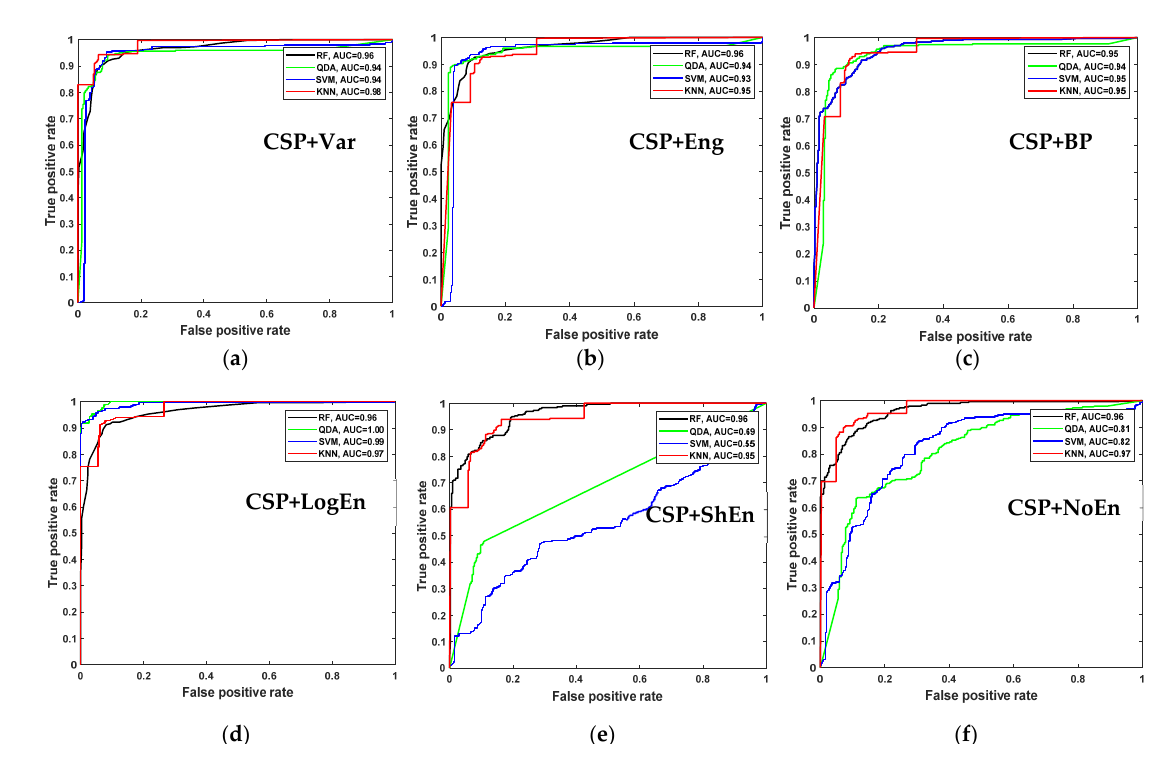
Figure 10. ROC and AUC of on–PD vs. HC classification based on features extracted from ( a ) CSP+Var, ( b ) CSP+Eng, ( c ) CSP+BP, ( d ) CSP+LogEn, ( e ) CSP+ShEn and ( f ) CSP+NoEn.